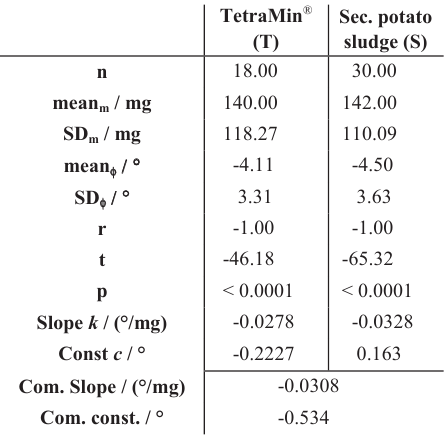
Tab.1: Covariance analysis of the regression slopes of mass (m) against phase ( φ ) at 90 kHz of worms fed with either TetraMin® (T) or secondary potato sludge (S) as shown in Fig. 5. SD means standard